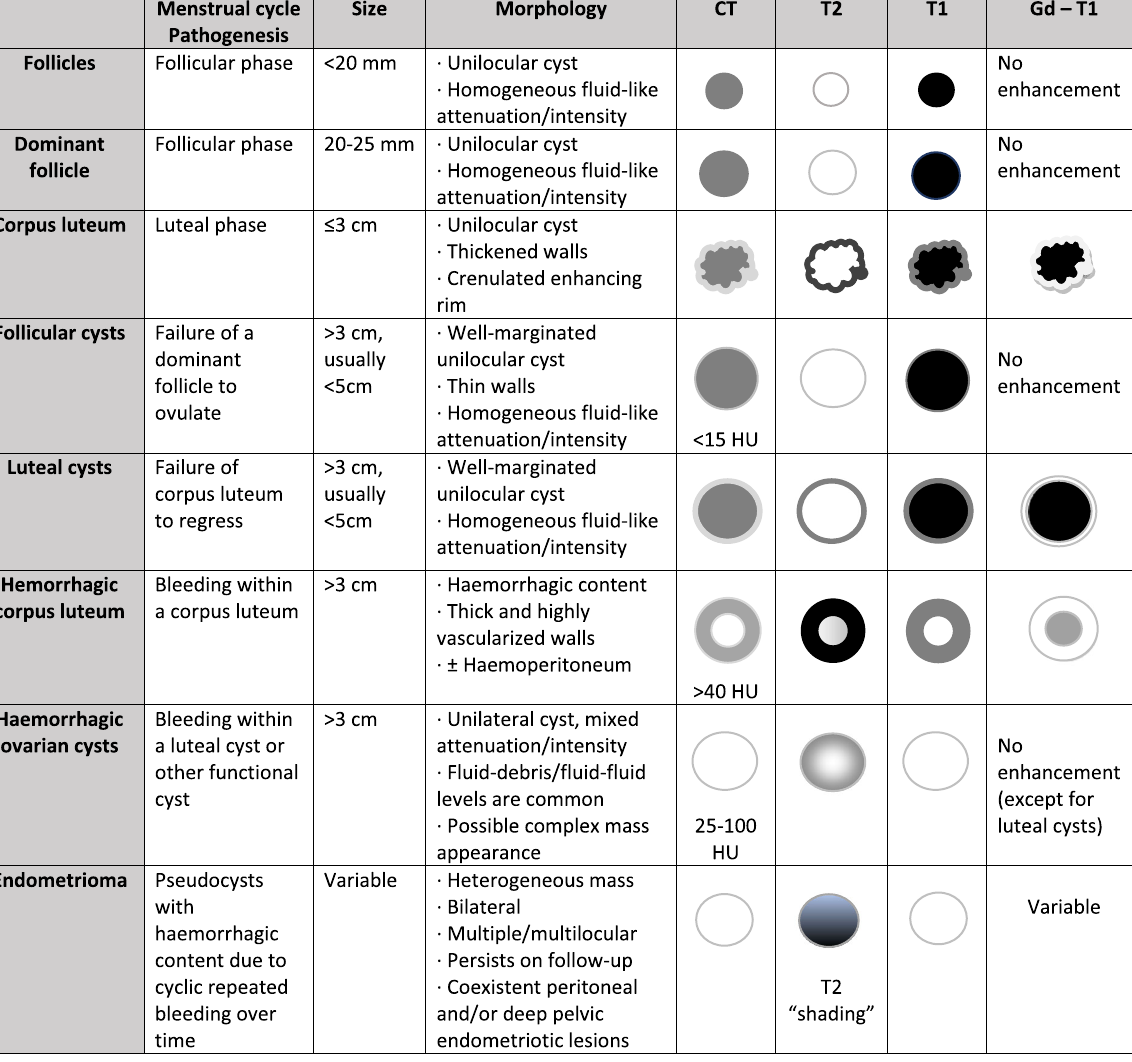
Table 3 Chart summarising CT and MR imaging findings of ovarian cysts